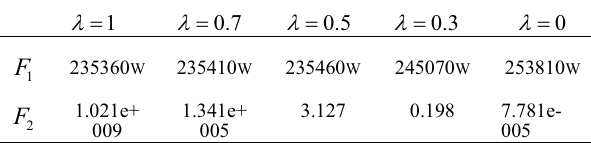
Table 8. Value of